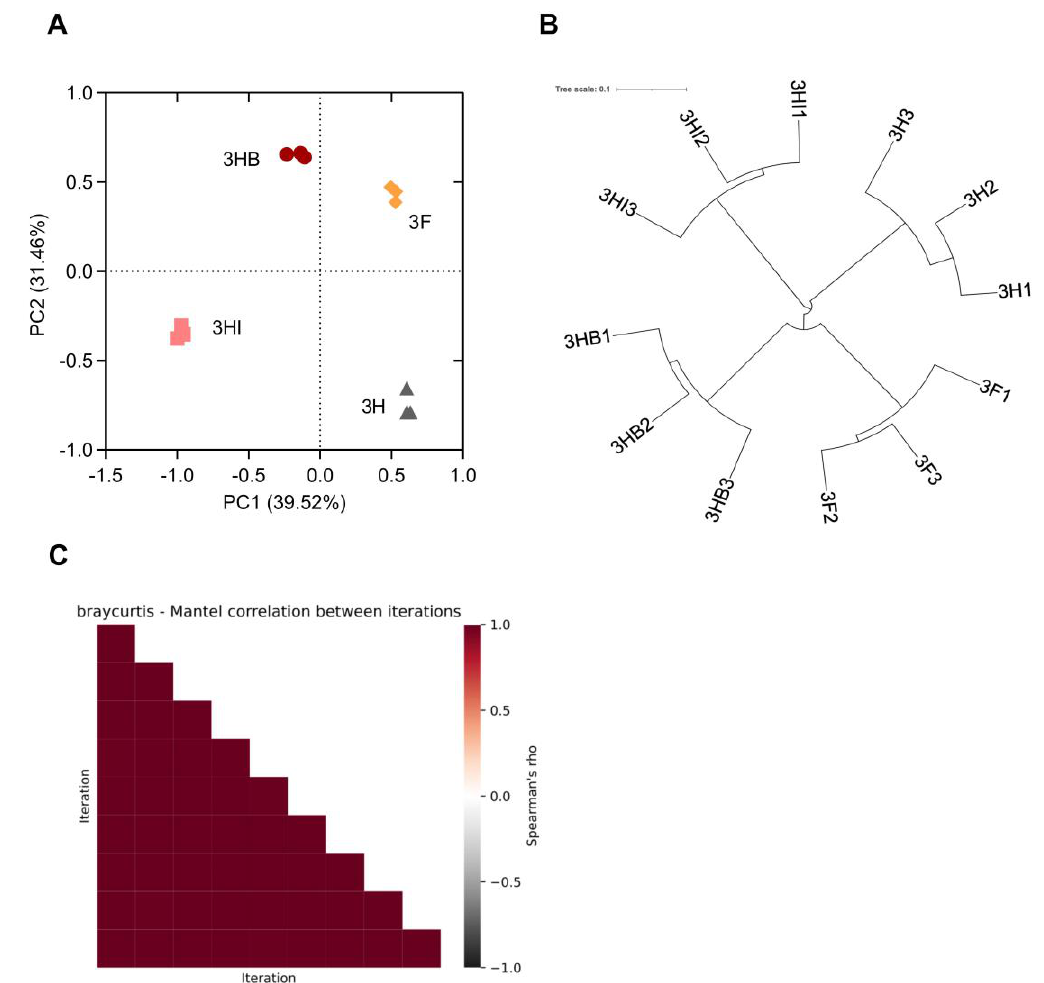
Figure 6. Beta diversity analysis of microbial composition: ( A ), Principal Component Analysis; ( B ), Hierarchical clustering analysis; ( C ), Mantel correlation. Half-dose PK-fertilizer, 3H; half-dose PK-fertilizer and free-cell strain 40a, 3HI; half-dose PK-fertilizer and encapsulated strain 40a, 3HB; full-dose PK-fertilizer, 3F.